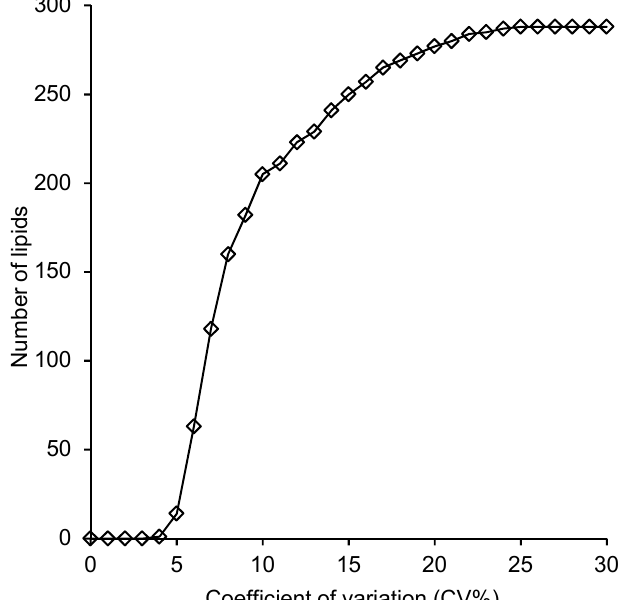
Figure 5. Coefficient of variation of the batch-to-batch extraction. The CV% was calculated for ( n = 49) samples ( n = 7/day) over two months. Out of 293 lipid species, 274 lipid species showed a CV% less than